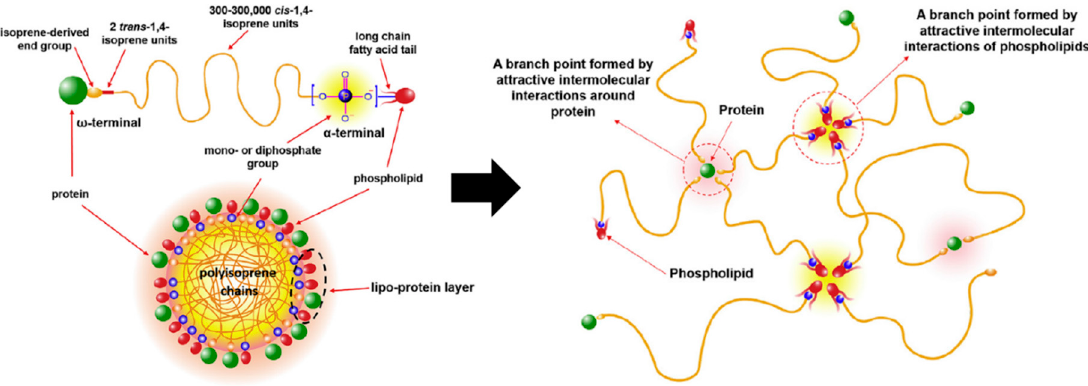
Figure 2. The model of rubber particles and non-covalent interaction in natural rubber molecules [25]. Adapted from [25], Copyright 2018, with permission from Elsevier.